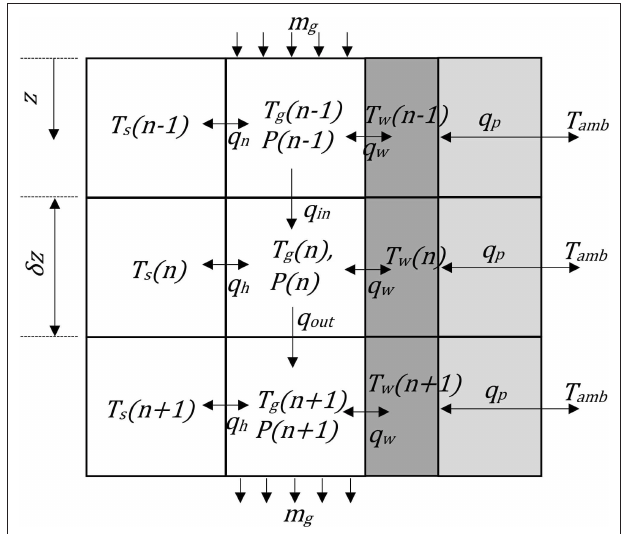
FIGURE 10 | One-dimensional finite element model of thermocline showing solid and gas elements, vessel wall, insulation, and peripheral heat leak.